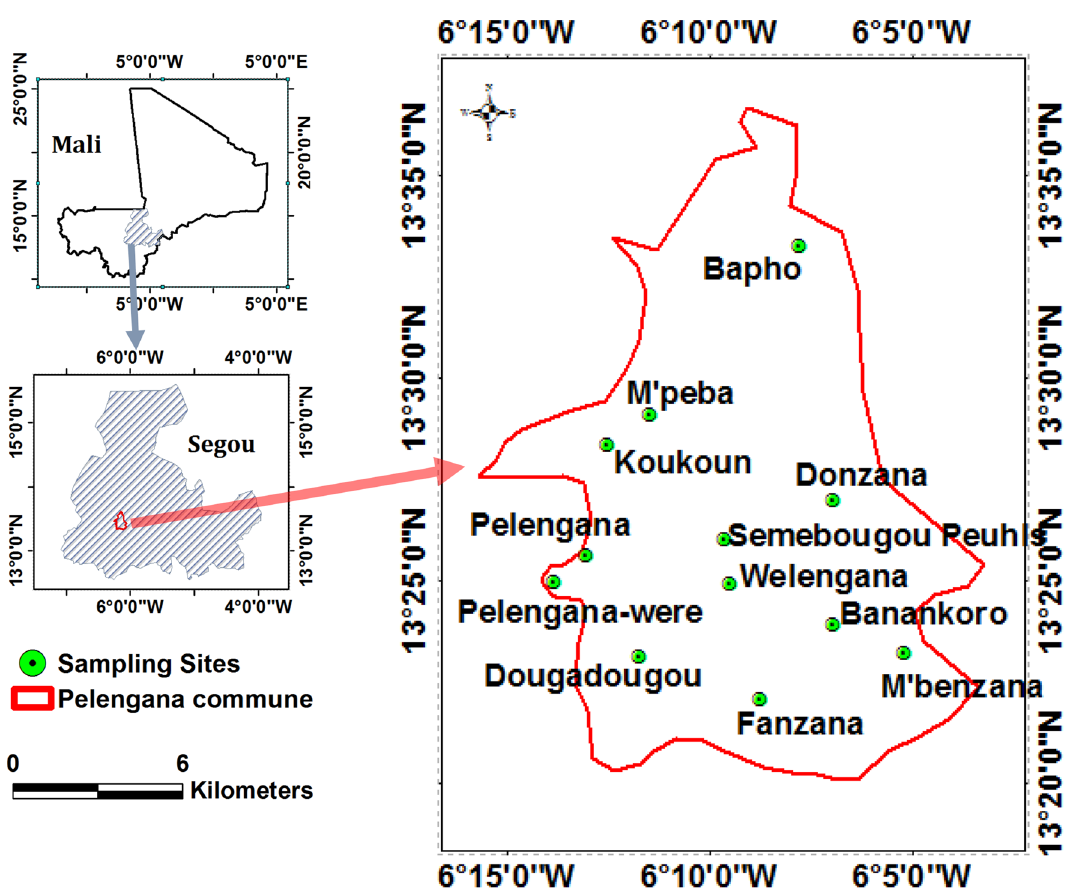
Fig. 1 Map of the study zone in